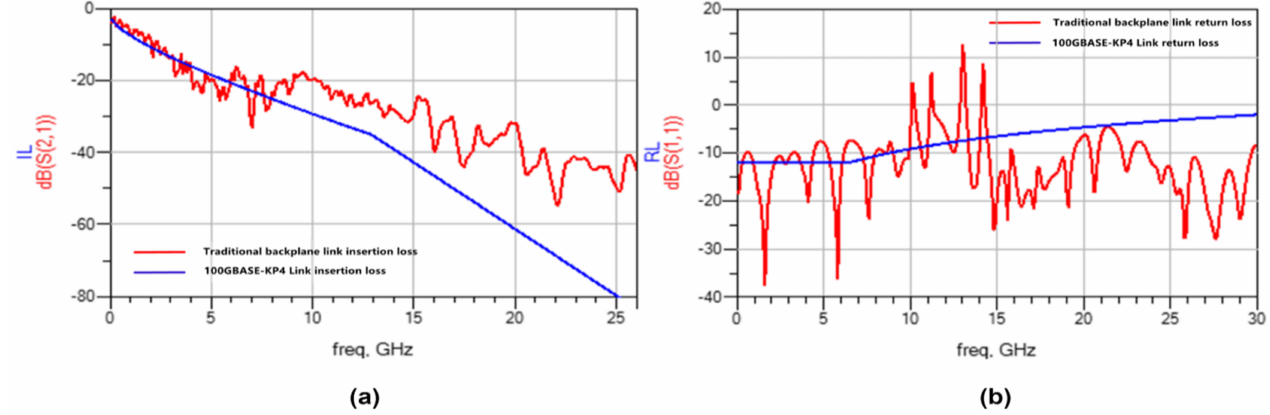
Figure 13. ( a ) Insertion loss diagram of traditional backplane link S-parameter model; ( b ) return loss diagram of traditional backplane link S-parameter model.